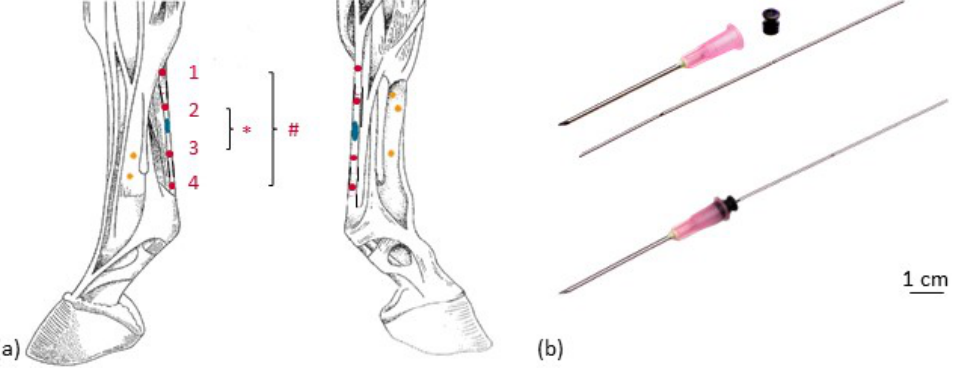
Figure 3. Implantation of the tantalum beads. ( a ) Left forelimb, lateral (left) and medial (right) view; yellow: bone markers, red: tendon markers with intermarker distances M1 to M4 (#) and M2 to M3 (*); blue: collagenase. ( b ) Implantation instrument for tendon markers (separated and mounted).